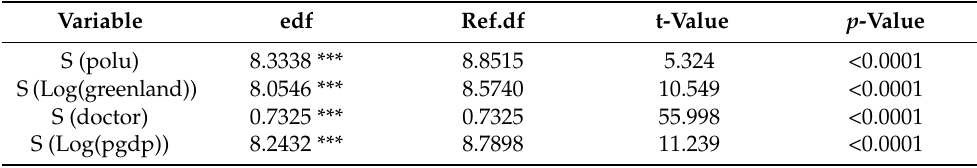
Table 5. The nonlinear effect result of environmental status on mortality.